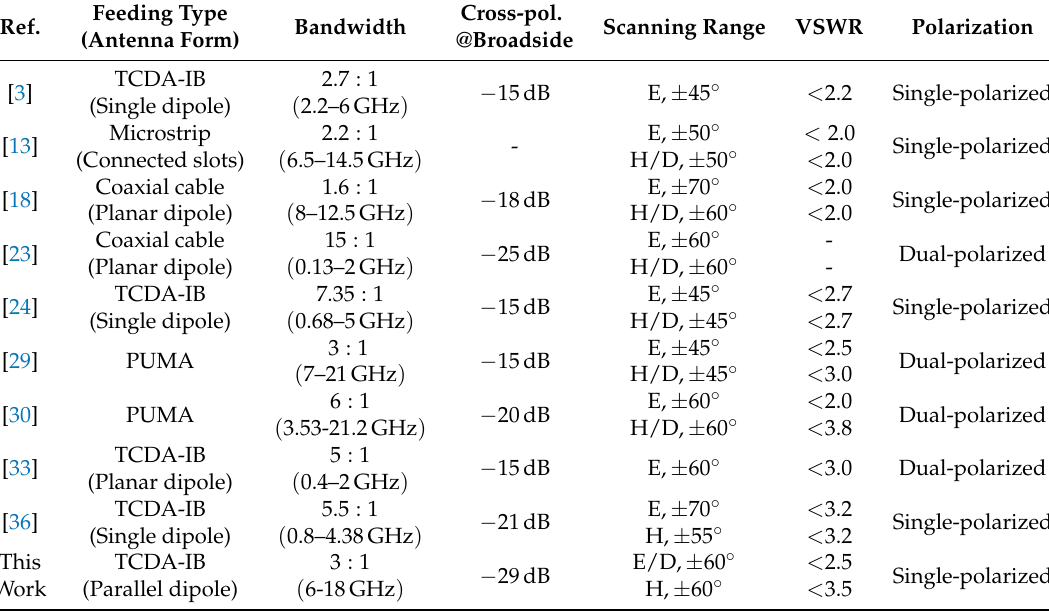
Table 1. Comparison of array performance with the reported